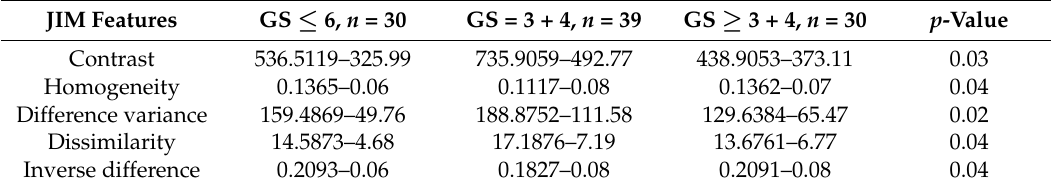
Table 2. Summary of five significant JIM features (Median-IQR) between Gleason score (GS)